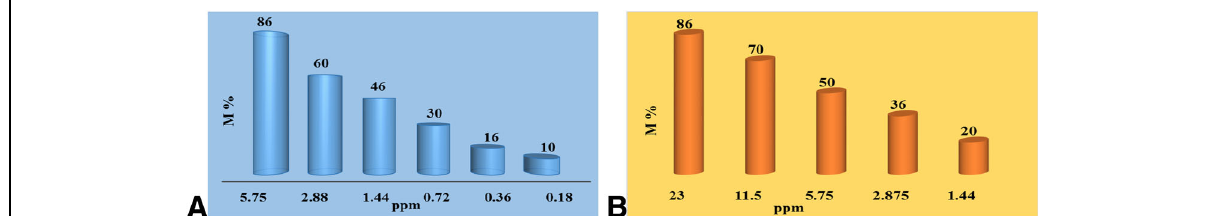
Fig. 9 The mortality percentages of fourth-instar larvae for AgNPS@P to a laboratory and b field strains of S.